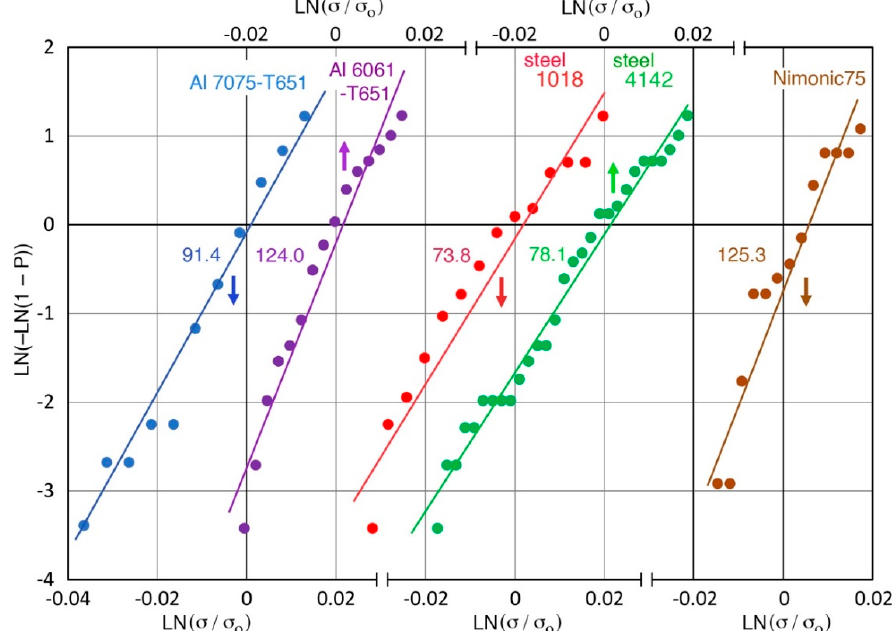
Figure 1. Weibull plots of the tensile strength of five structural alloys: Al 7075-T651 (in blue symbols), Al 6061-T651 (in purple), steel 1018 (in red), steel 4142 (in green), and Nimonic ® 75 Ni alloy (in brown). Data from [24,25]. Values of m are shown. The horizontal axis is shifted to avoid overlaps.